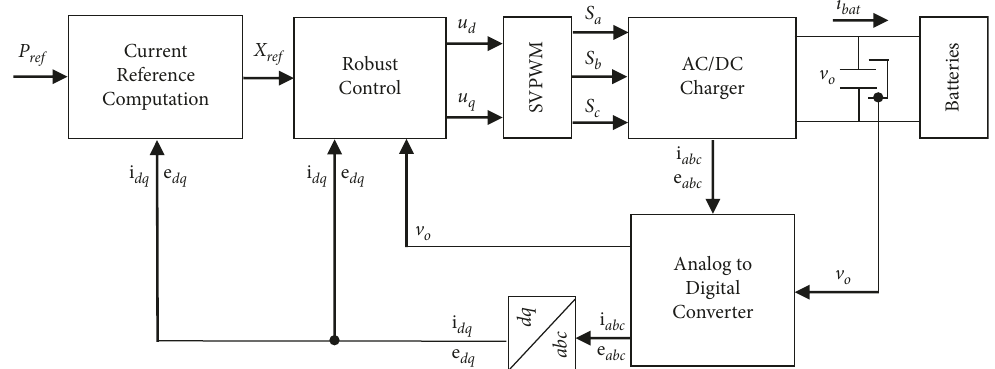
Figure 4: Block diagram of discharging mode control.